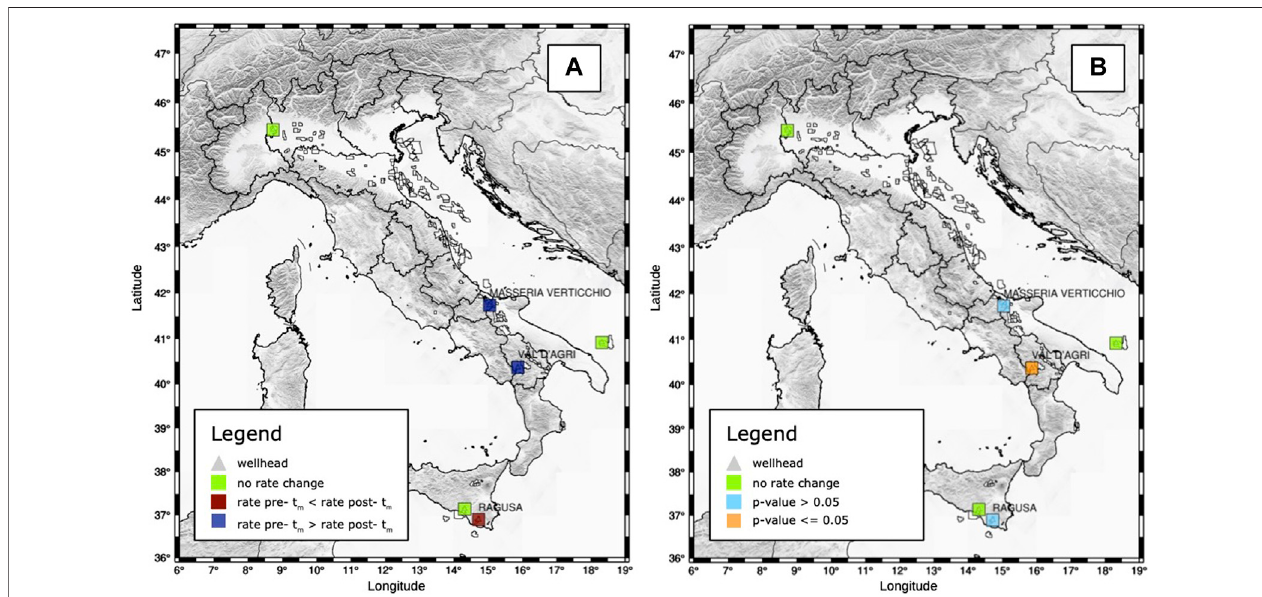
FIGURE 7 | Map of the pre – and post – t m seismicity rate changes (A) and p values (B) for the six oil-producing leases analyzed in this work considering the seismicity located within δ x (cid:1) 5 km from producing wells.